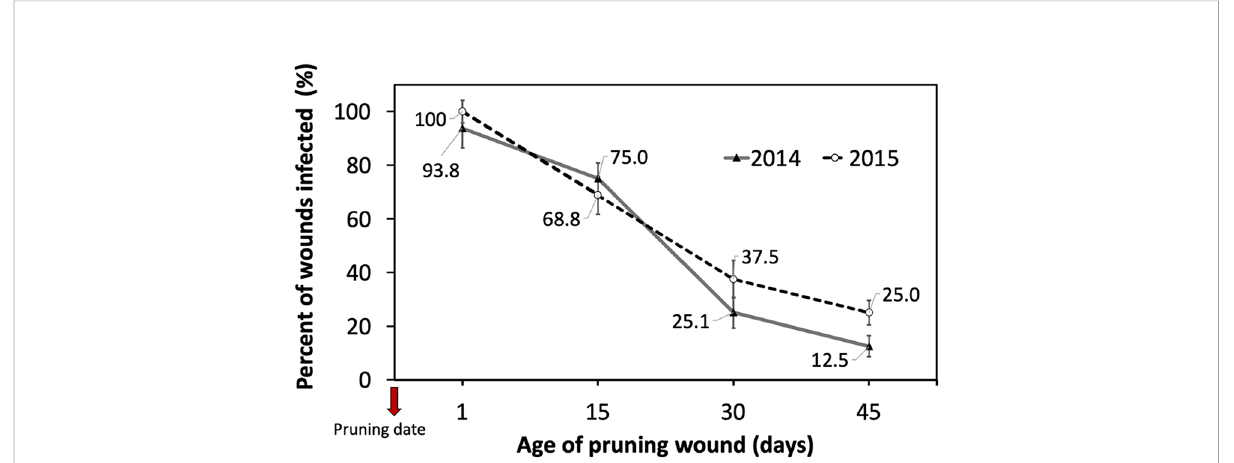
FIGURE 3 Percent of grapevine pruning wounds infected expressed as mean (%) ± standard deviation of rooted cutting of one-year-old cv. Cabernet Sauvignon by arti fi cial inoculation of 40 uL of a conidial suspension (10 5 conidia/mL) of Phaeomoniella chlamydospora on pruning wounds of different ages (1, 15, 30, and 45 days after pruning) under greenhouse conditions (with temperature between 15-24°C and 70-85% HR) during four months in dormant seasons 2014 (line) and 2015 (segmented